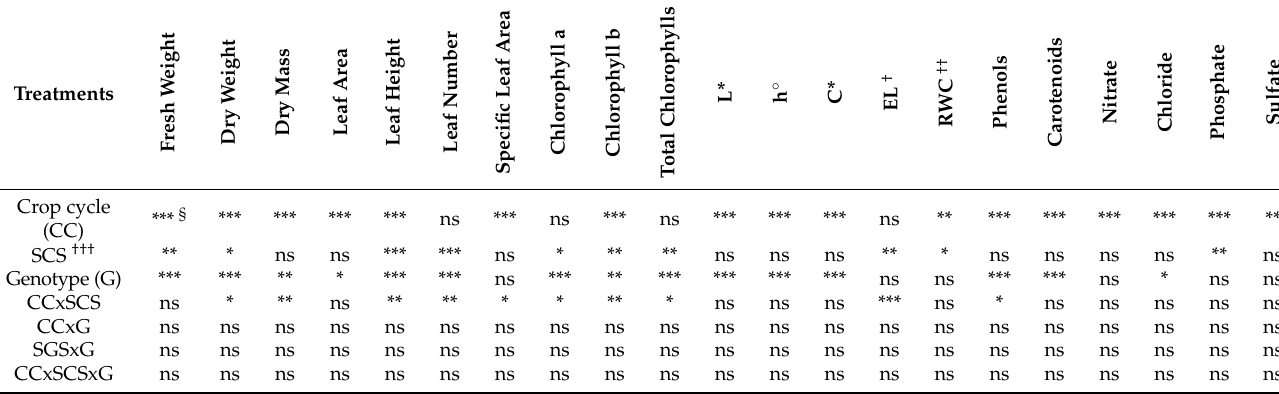
Table 4. The significance of F test of ANOVA for the effects of the crop cycle (CC), soilless cultivation system (SCS), and genotype (G), and their interactions, on yield, bio-morpho-physiological traits, and the main inorganic and antioxidant compound concentrations in oak-leaf lettuce.